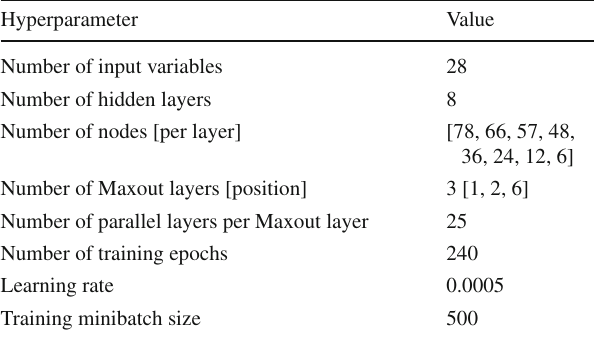
Table 3 List of optimised hyperparameters used in the DL1